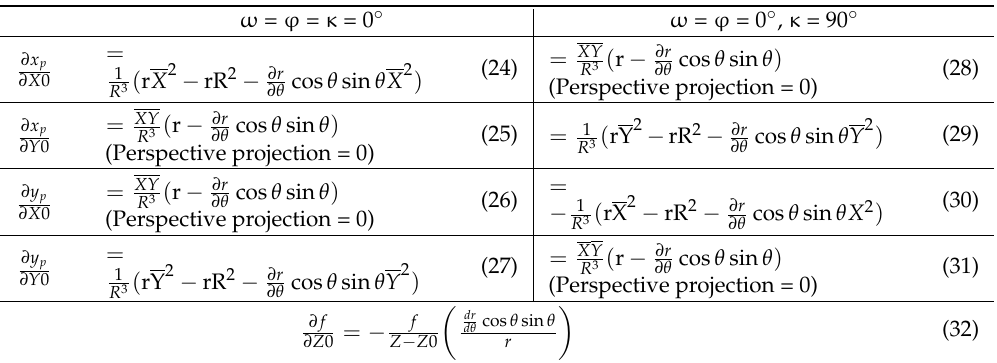
Table 1. Partial derivatives